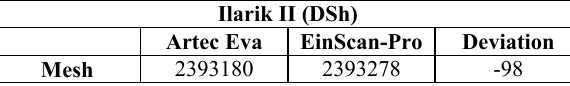
Table 2. DSh analysis of the “Lurrak” model